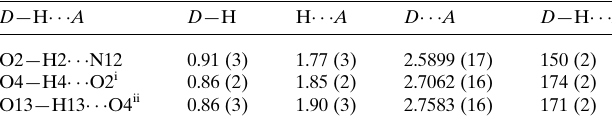
Table 2 Hydrogen-bond geometry (A˚ , (cid:2) ) for 2 .